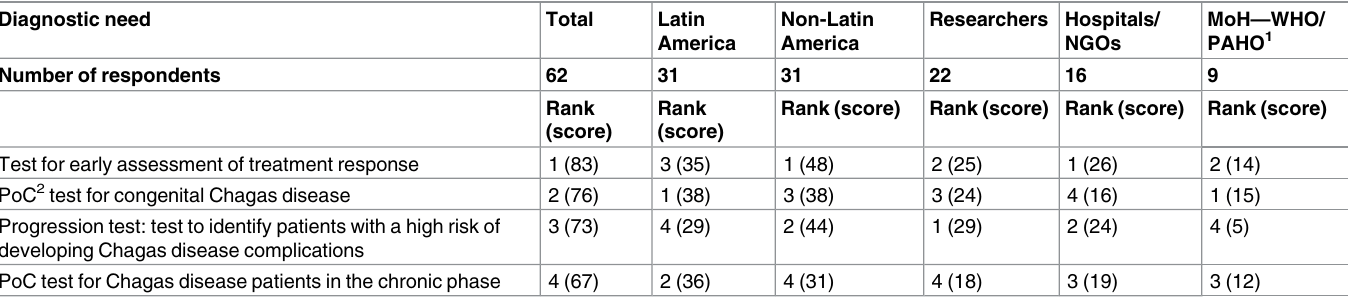
Table 2. Ranking diagnostic needs for Chagas disease (June